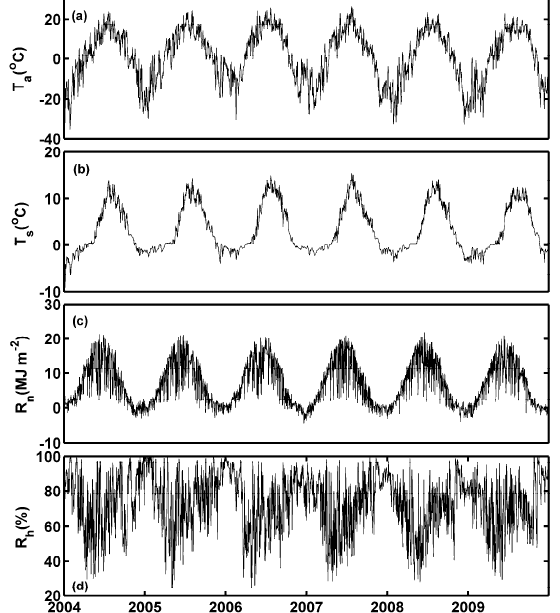
Figure 1. Daily values of environmental variables during the study period. ( a ) Air temperature above the canopy ( T a ); ( b ) 5-cm depth soil temperature ( T s ); ( c ) net radiation ( R n ); ( d ) relative humidity ( R h ). Table 1. Statistical parameters of flux tower-measured daily environmental variables including air temperature ( T a , ◦ C), net radiation ( R n , mol · m − 2 ), relative humidity ( R h , %), soil